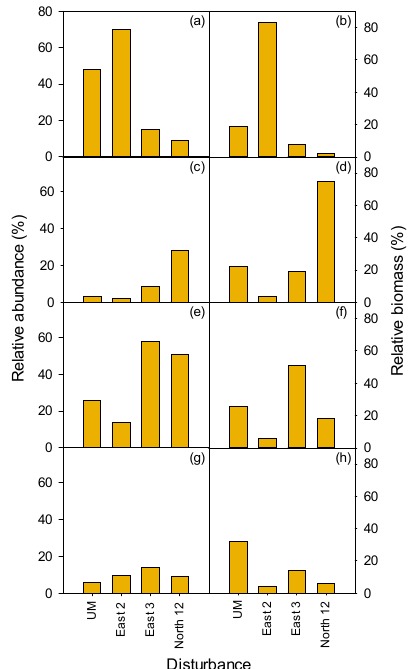
Figure 8. The Menziesia ferruginea (MEFE) habitat type phase 30 years after disturbance and the relative abundance values (%) for trees of ( a ) Abies lasiocarpa , ( c ) Larix occidentalis , ( e ) Picea engelmannii , and ( g ) Pseudotsuga menziesii var. glauca , along with their respective relative biomass values (%) ( b , d , f , h ). Note: x-axis values progress from undisturbed forest (left) to the highest severity disturbance (right); see Table 1 for disturbance category descriptions.